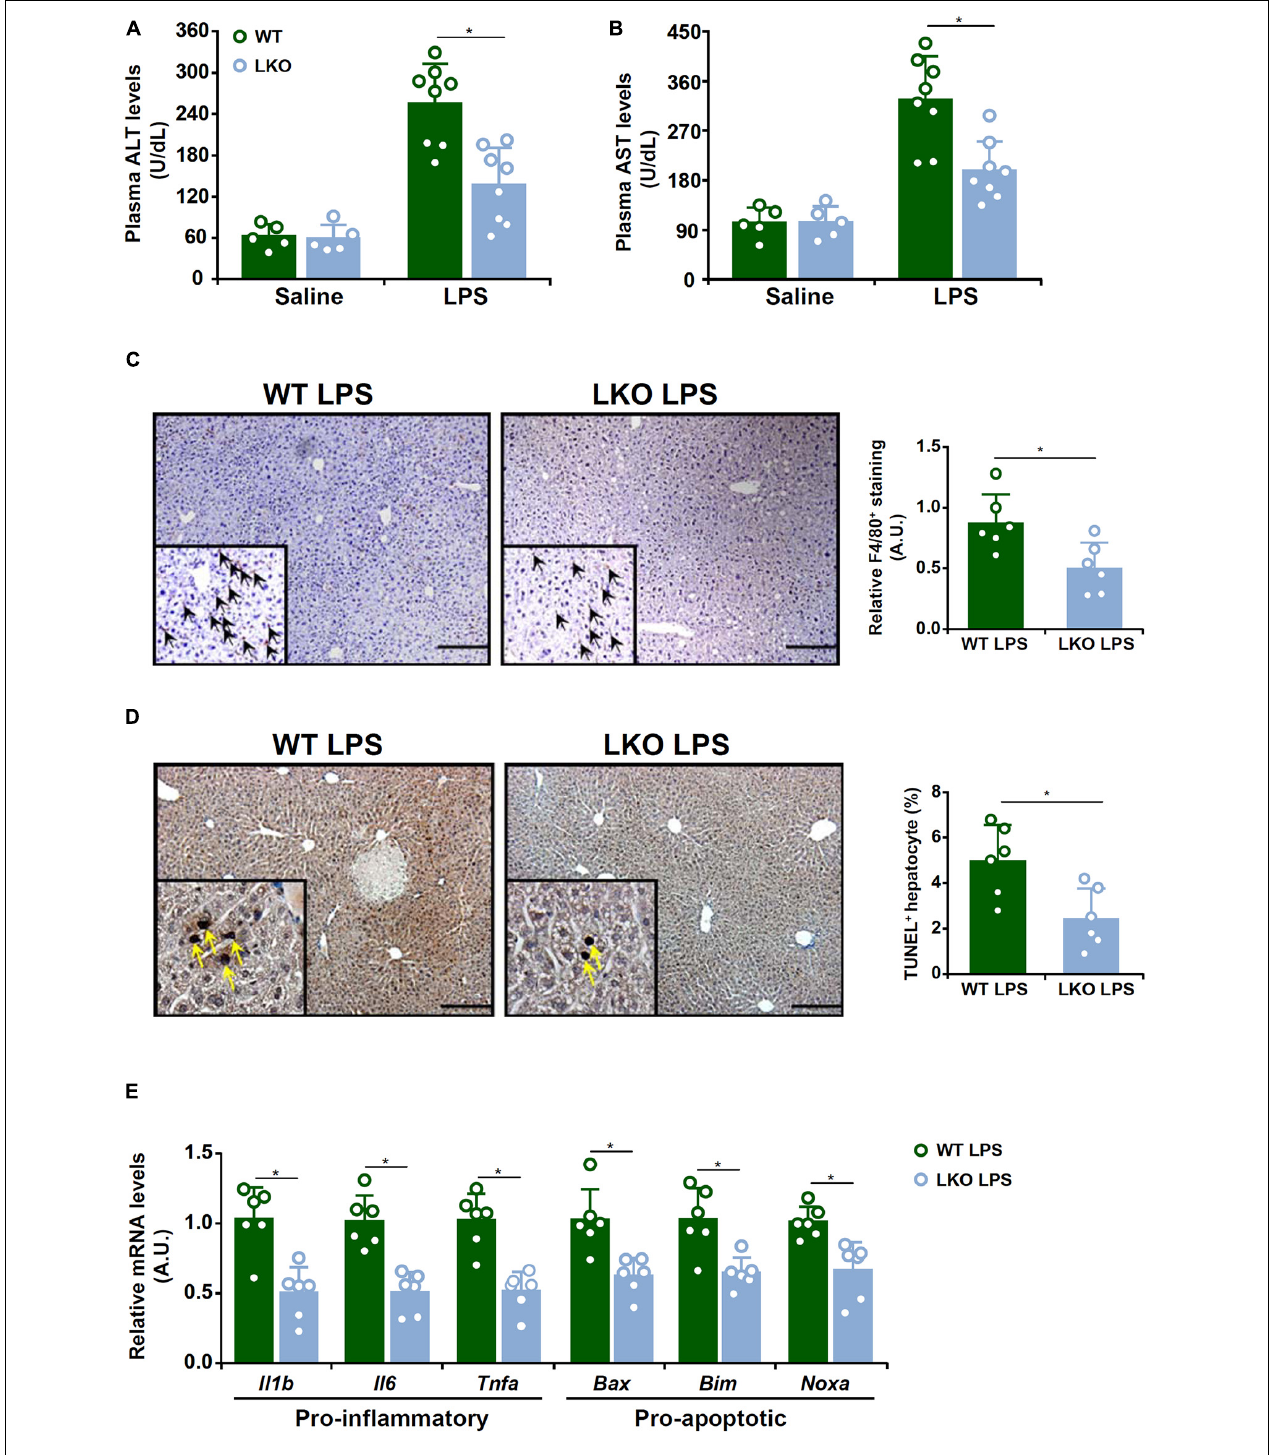
FIGURE 1 | BRG1 deficiency in hepatocyte alleviates LPS-induced liver injury. WT and BRG1 LKO mice were injected peritoneally with LPS (15 mg/kg) and sacrificed 24 h after the injection. (A) Plasma ALT levels. N = 5 mice for the saline groups and N = 8 mice for the LPS groups. (B) Plasma AST levels. N = 5 mice for the saline groups and N = 8 mice for the LPS groups. (C) Paraffin sections were stained with F4/80. N = 6 mice for each group. (D) Paraffin sections were stained with TUNEL. N = 6 mice for each group. (E) Gene expression levels were examined by qPCR. N = 6 mice for each group.